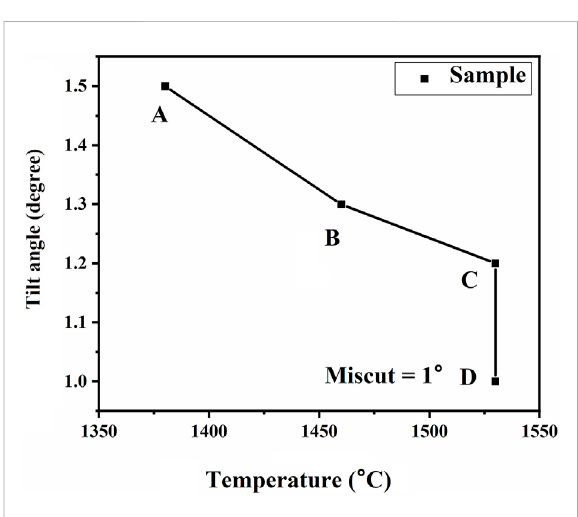
FIGURE 5 The in fl uence of growth temperature on the tilt